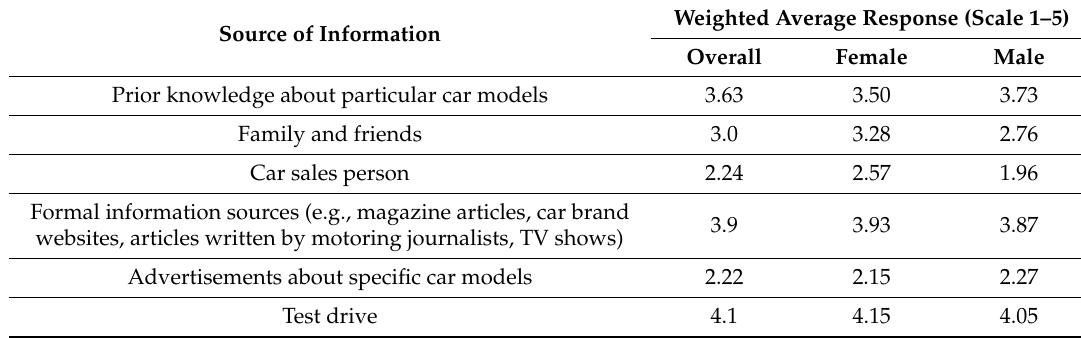
Table 4. Importance of information sources (Questionnaire 2: Question 6) ( n =